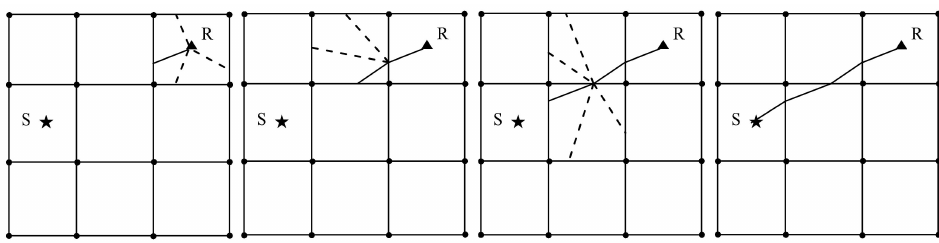
Figure 4. Sketch map of raypath tracing. S is the source, R is the receiving point, the dotted lines represent the possible raypath from all directions and the solid line SR represents the determined minimum-traveltime raypath from the source S to the receiving point